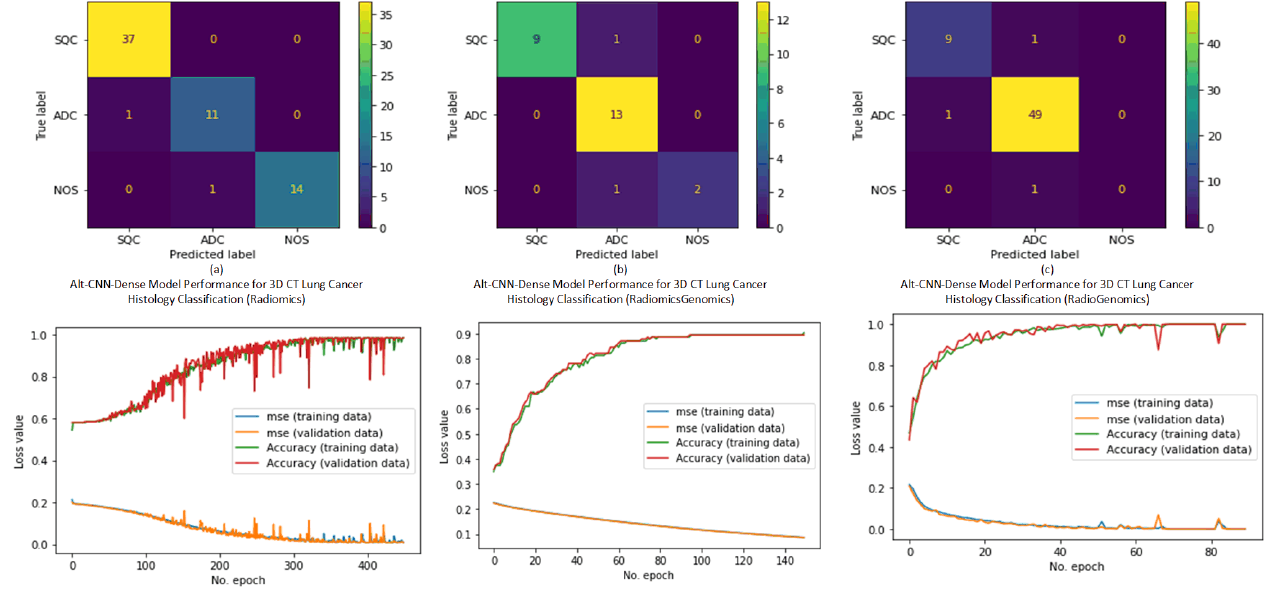
Figure 12. Summary of Phenotyping Results presenting confusion matrices and learning curves on three datasets ( a ) Radiomics ( b ) Radiomics Genomics ( c ) Radio Genomics. The learning curves present mean square error (mse) for training and testing and Accuracy for training and testing